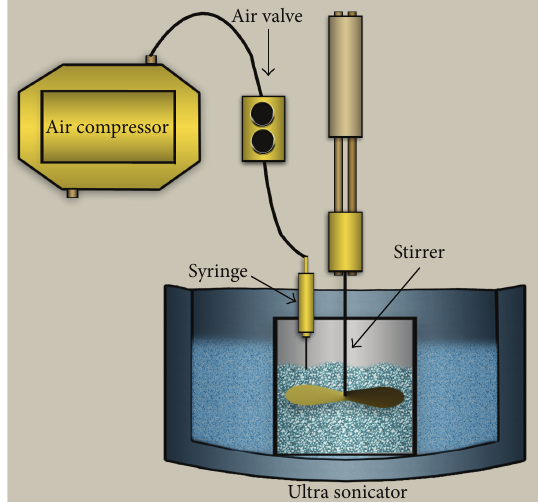
Figure 6: Schematic representation of the precipitation method